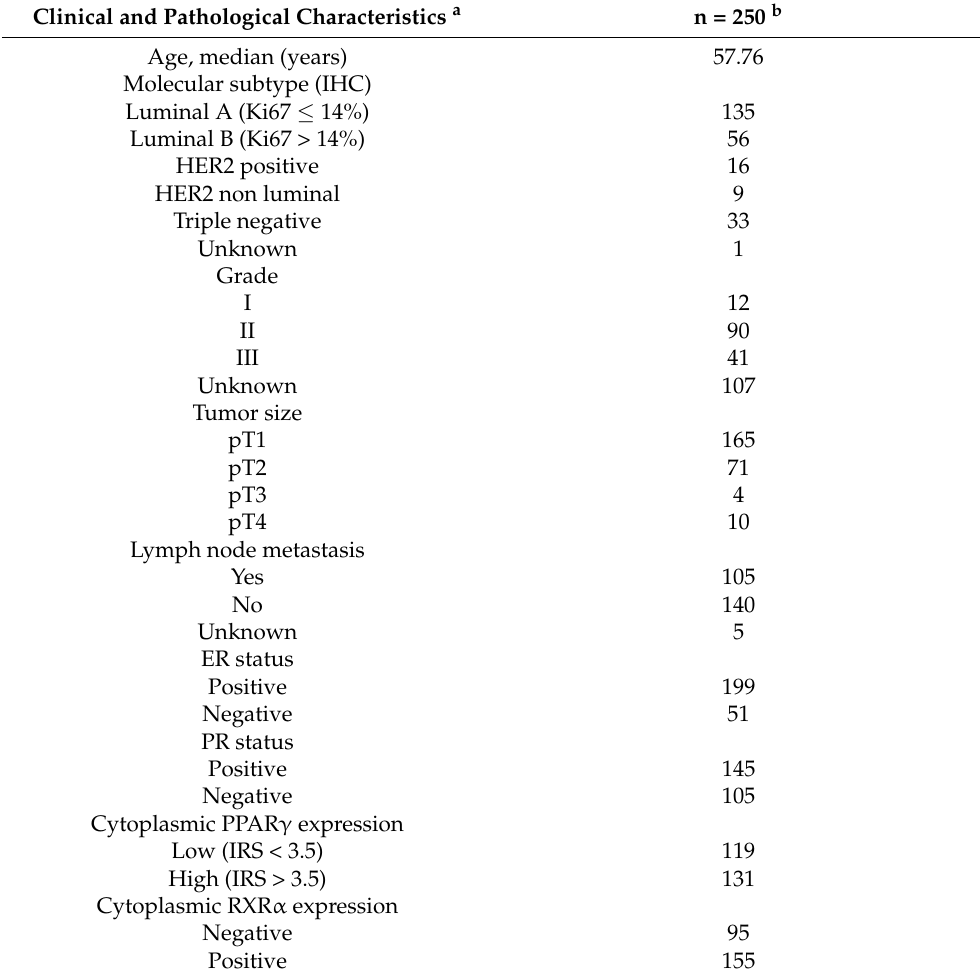
Table 1. Clinical and pathological characteristics of all